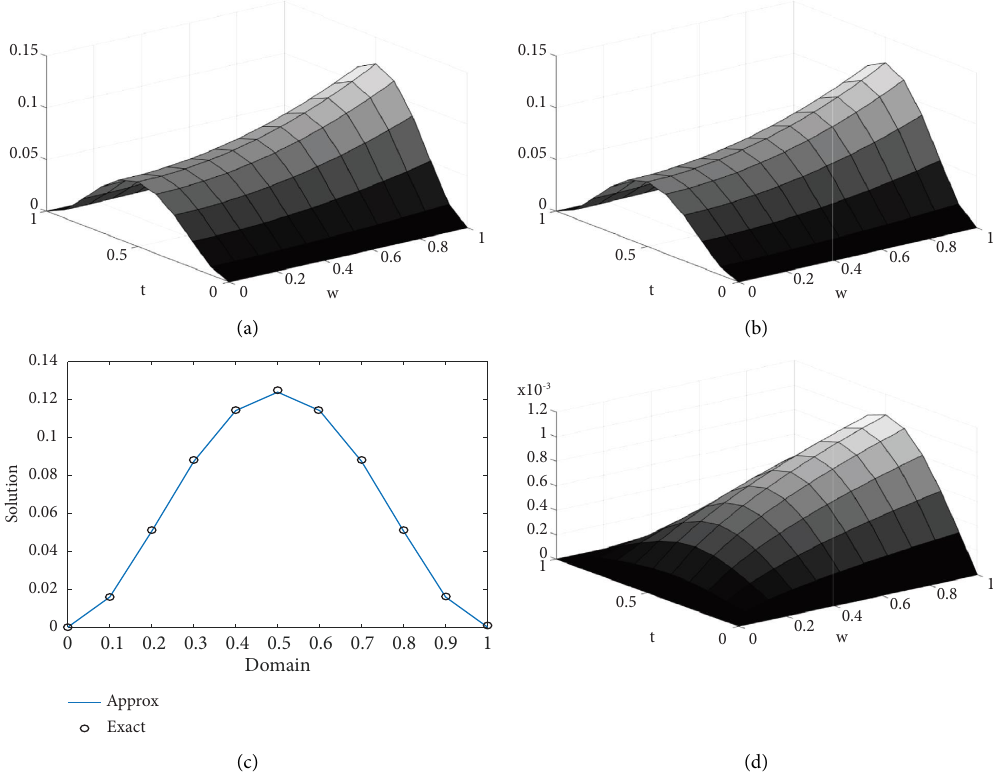
Figure 5: Graphical solution of approximate, exact, and error of Y at h � Δ t � 0 . 1 and plot at t � 1. (a) Approximate solution. (b) Exact solution. (c) Approximate vs Exact. (d)